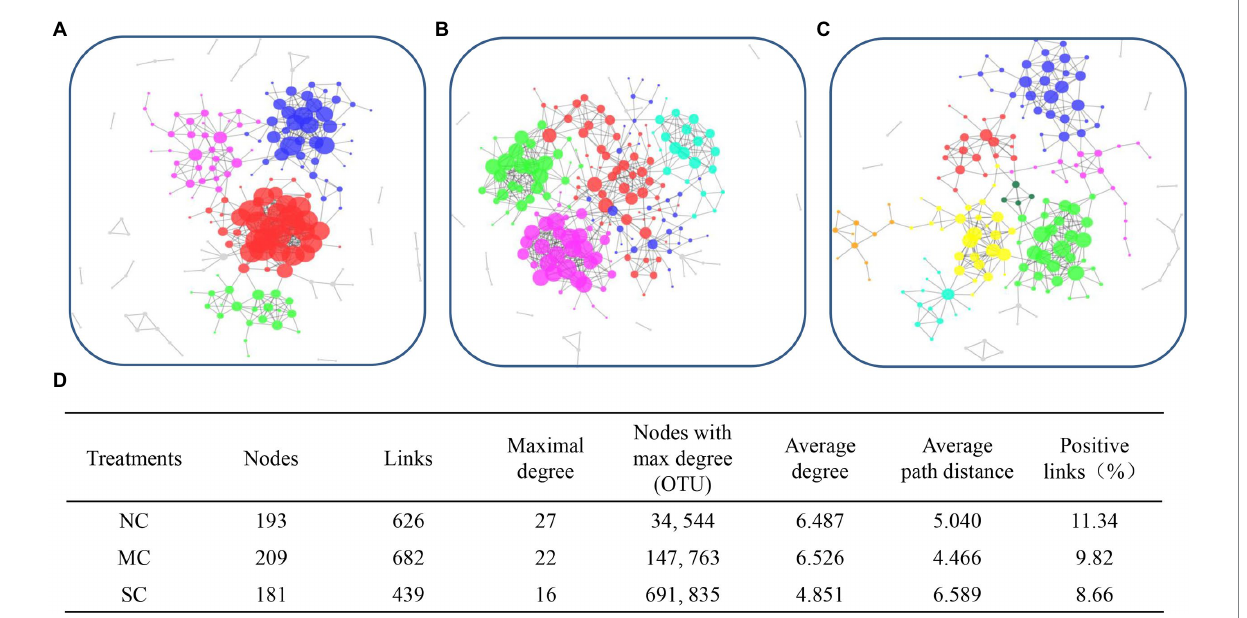
FIGURE 6 The network interactions of microbial communities in the treatments NC (A) , MC (B) , and SC (C) , and detailed parameters of the networks (D) .